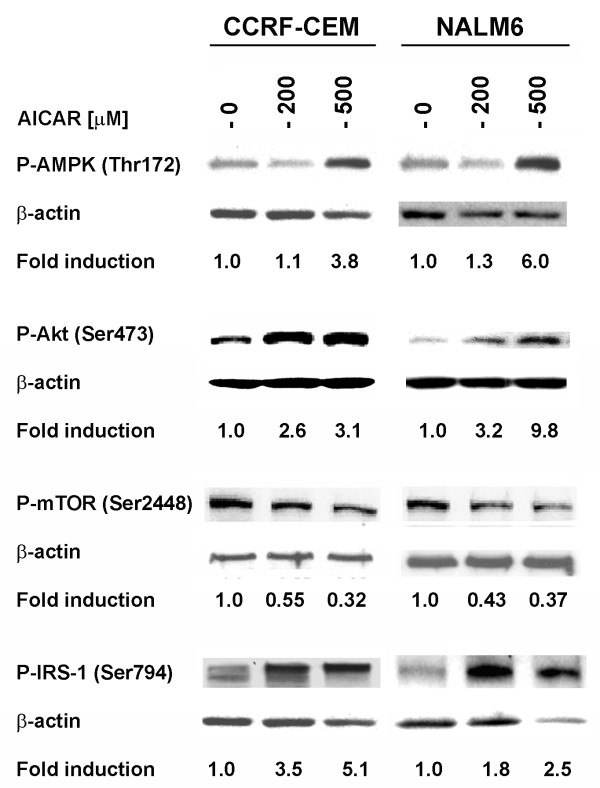
Activation of AMPK induces phosphorylation of IRS-1 at Ser794 and down-regulation of mTOR (Ser2448) in ALL cell lines. Western blot analysis of the expression of AMPK (Thr172), Akt (Ser473), mTOR (Ser2448) and IRS-1 (Ser794) in CCRF-CEM (T-ALL) and NALM6 (Bp-ALL) cells treated with AICAR (200 and 500 μM) and incubated for 24 h at 37°C. The density value of each band was normalized to β-actin level and expressed relative to control (shown as fold induction).